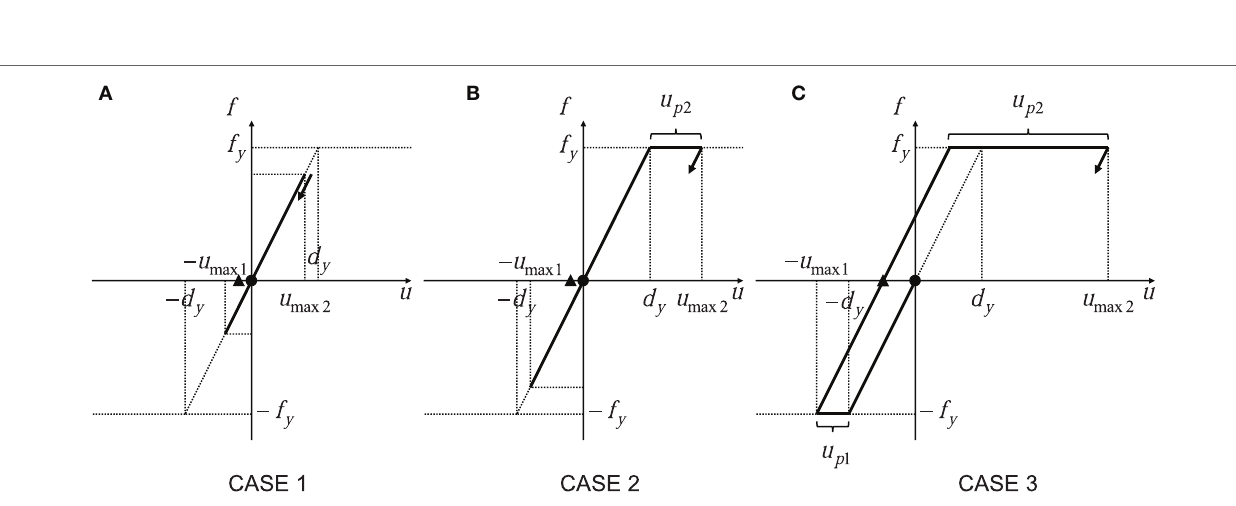
FigUre 2 | comparison of the proposed method with the previous method: (a) previous method (equivalent linearization of the structural model with the input unchanged) and (B) proposed method (transformation of the input into the double impulse with the structural model